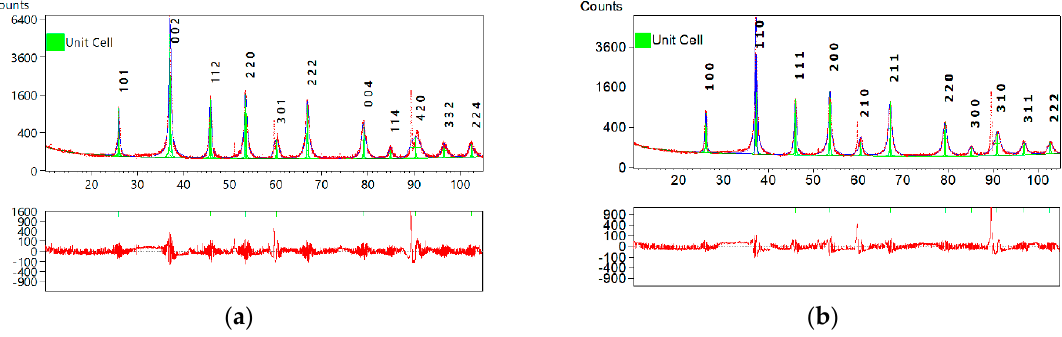
Figure 2. Results of searching the unit cell for ( a ) “upgraded” ( x = 5-4-3) and ( b ) “downgraded” ( x = 3-4-5) BST thin film deposited by the sol-gel method on the stainless-steel substrate and fired at T = 700 °C. Table 1. Results of the unit cell search calculations for the “upgraded” ( x = 5-4-3) BST thin film.